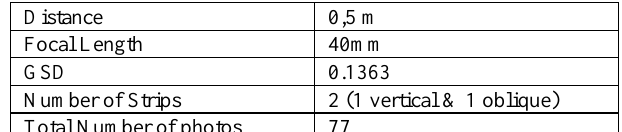
Table 3: Data acquisition details